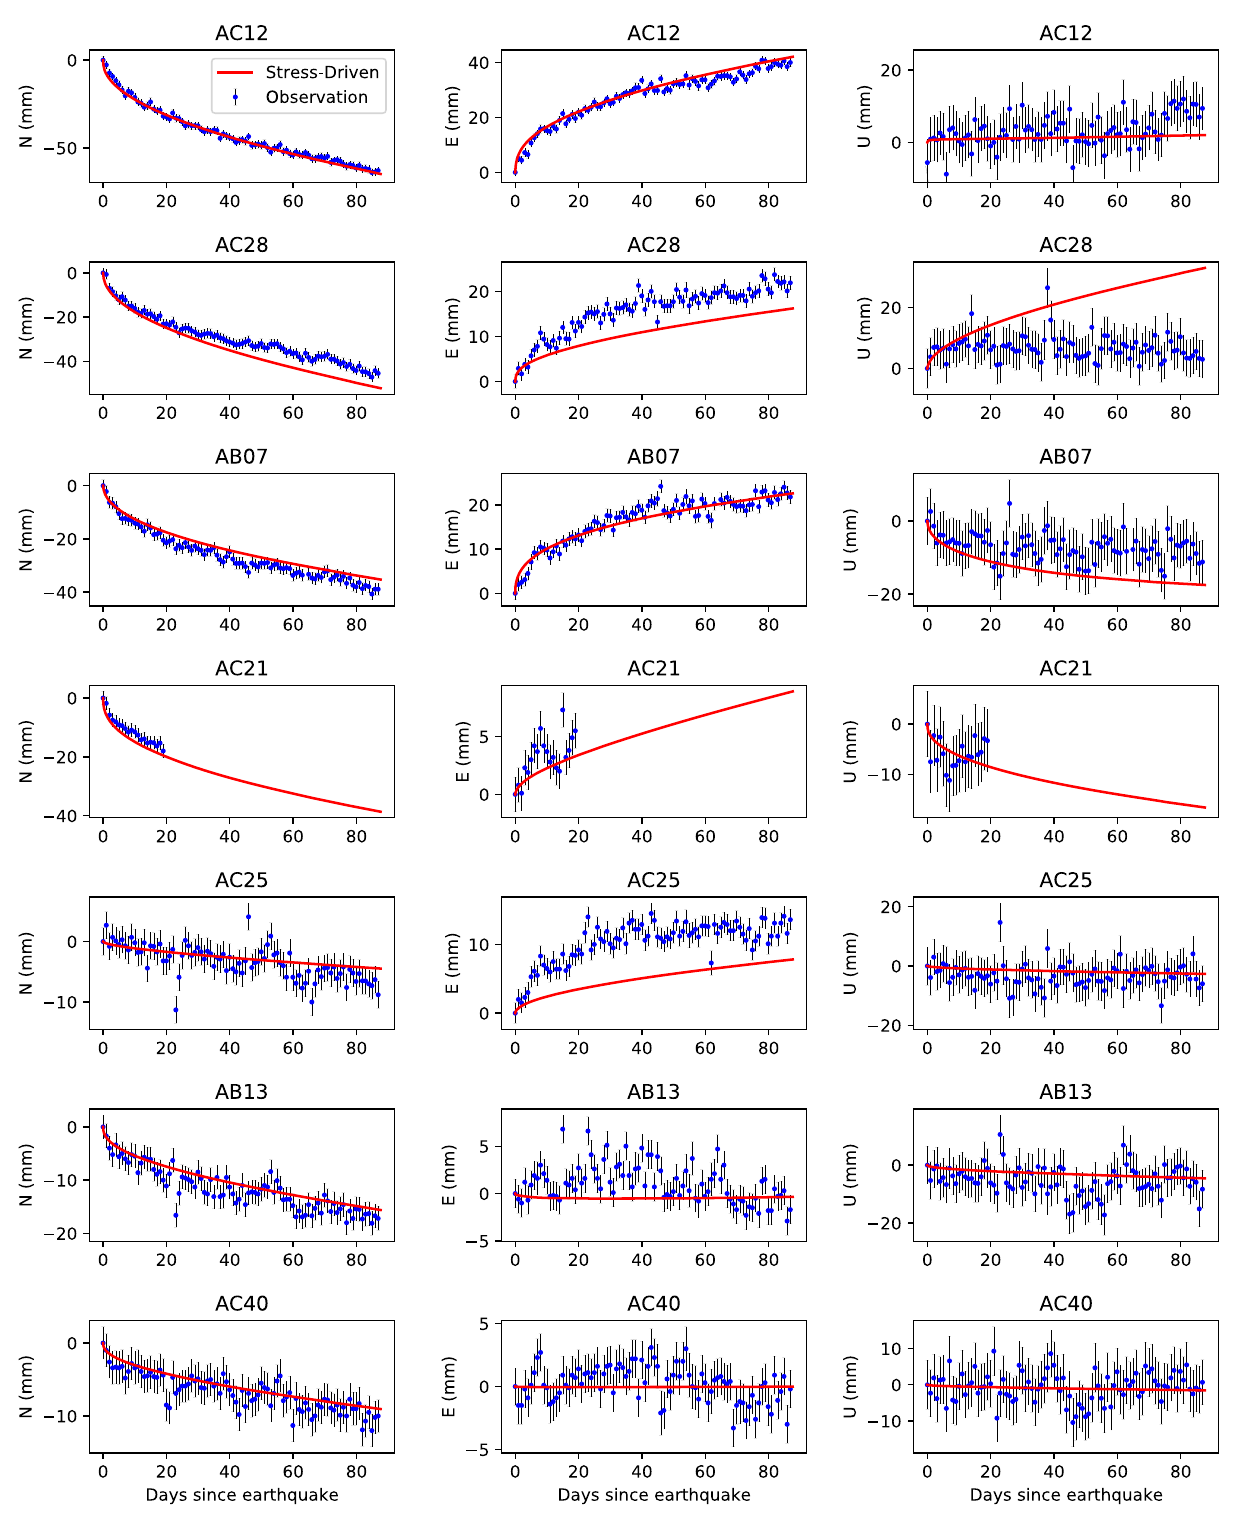
Fig. 4 Comparison of the Global Positioning System (GPS) observed and modeled postseismic position timeseries. Blue dots with error bars are observations and solid red lines represent predictions from the stress-driven afterslip model in the third scenario in the fi rst 87-day period.